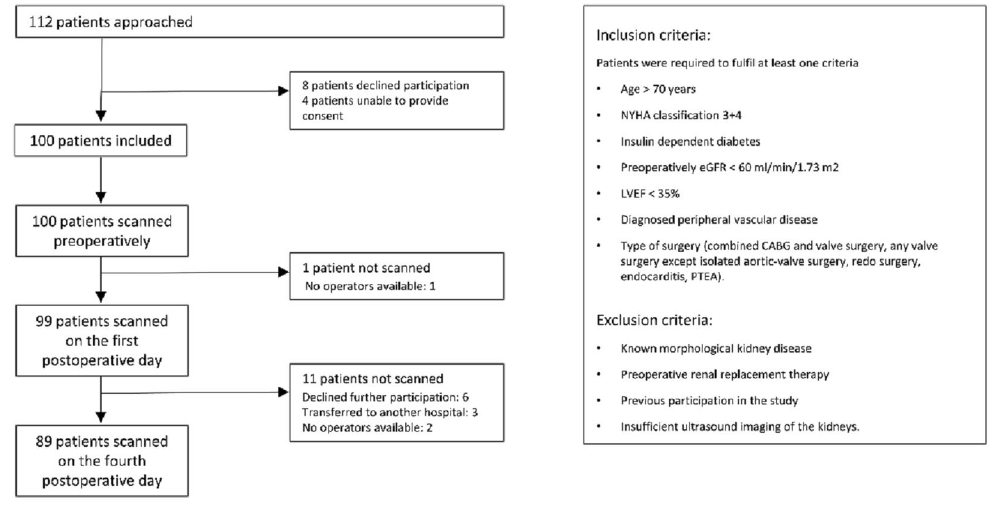
Figure 1. Flowchart of patients and ultrasound examinations in the study, including inclusion and exclusion